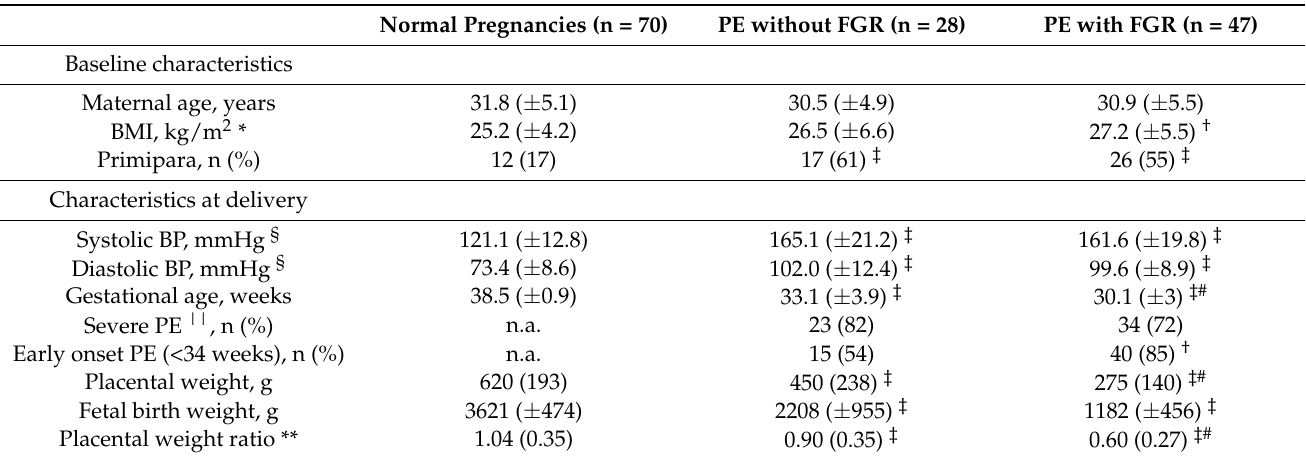
Table 1. Clinical characteristics of included